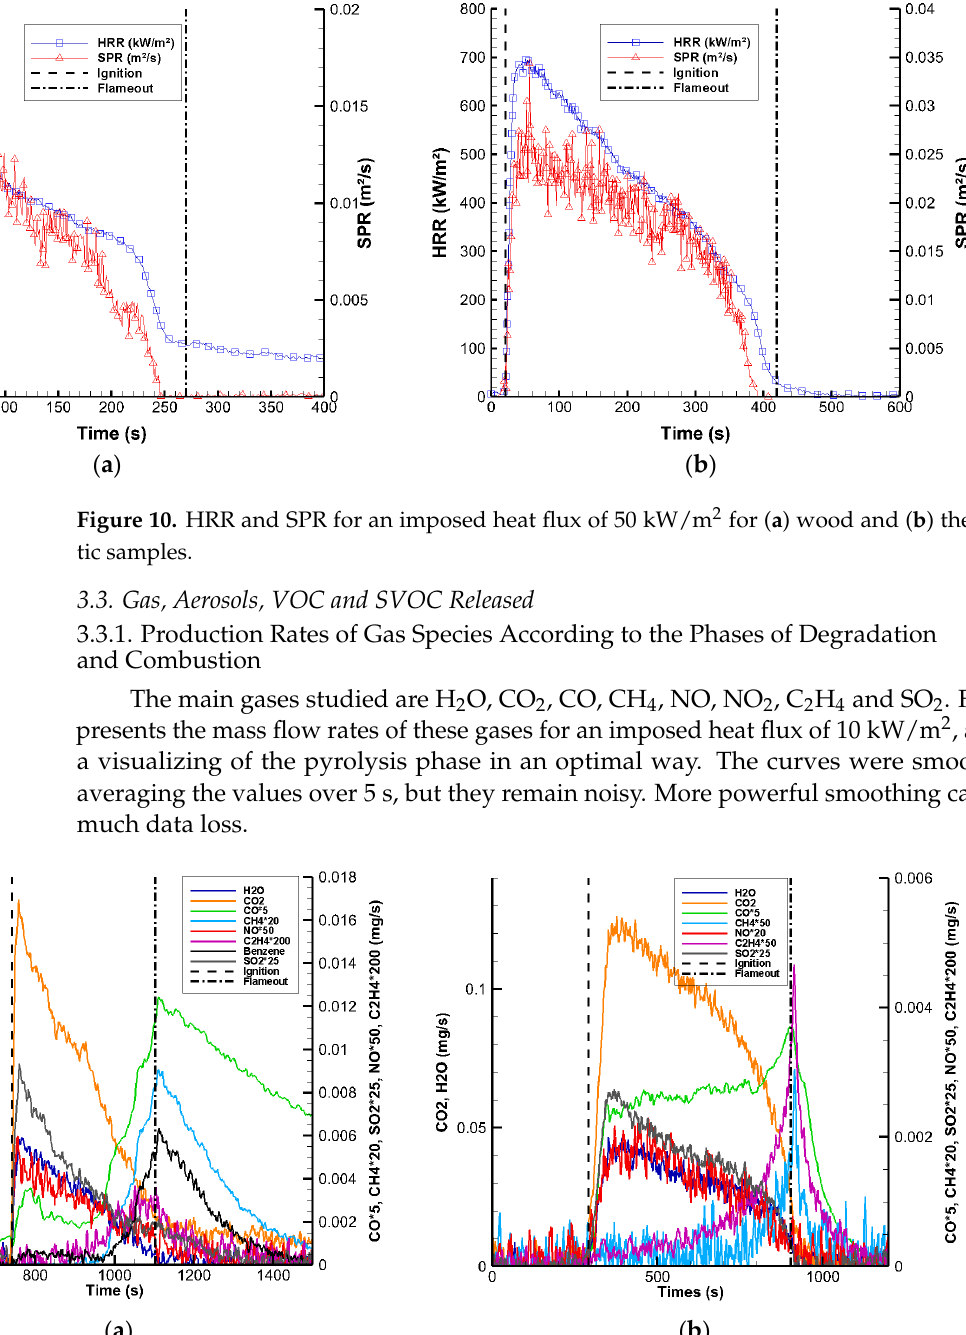
( b ) Figure 9. Smoke Extinction Area for an imposed heat fl ux of 10–50 kW/m 2 for thermoplastic samples during ( a ) pre-ignition phase and ( b ) fl ame phase. 3.2.4. Heat Release Rate and Smoke Production Rate (HRR and SPR) To analyse the simultaneous burning and smoke production of wood and thermo- plastic slabs, the HRR and SPR of both samples are plo tt ed in Figure 10 for the same im- posed heat fl ux of 50 kW/m 2 . Upon ignition, both samples emit a large amount of heat and smoke, resulting in sudden peaks in HRR and SPR. Thermoplastic samples (Figure 10b)